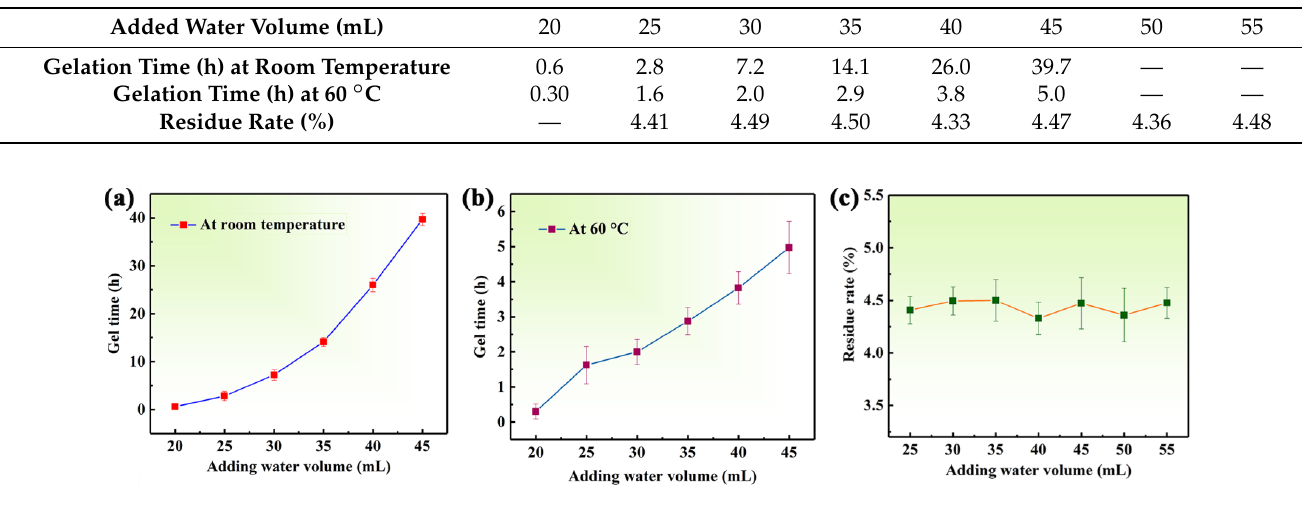
Figure 2. Effects of adding different volumes of water on ( a ) the gelation time at room temperature, ( b ) the gelation time at 60 °C, and ( c ) the residue rate.